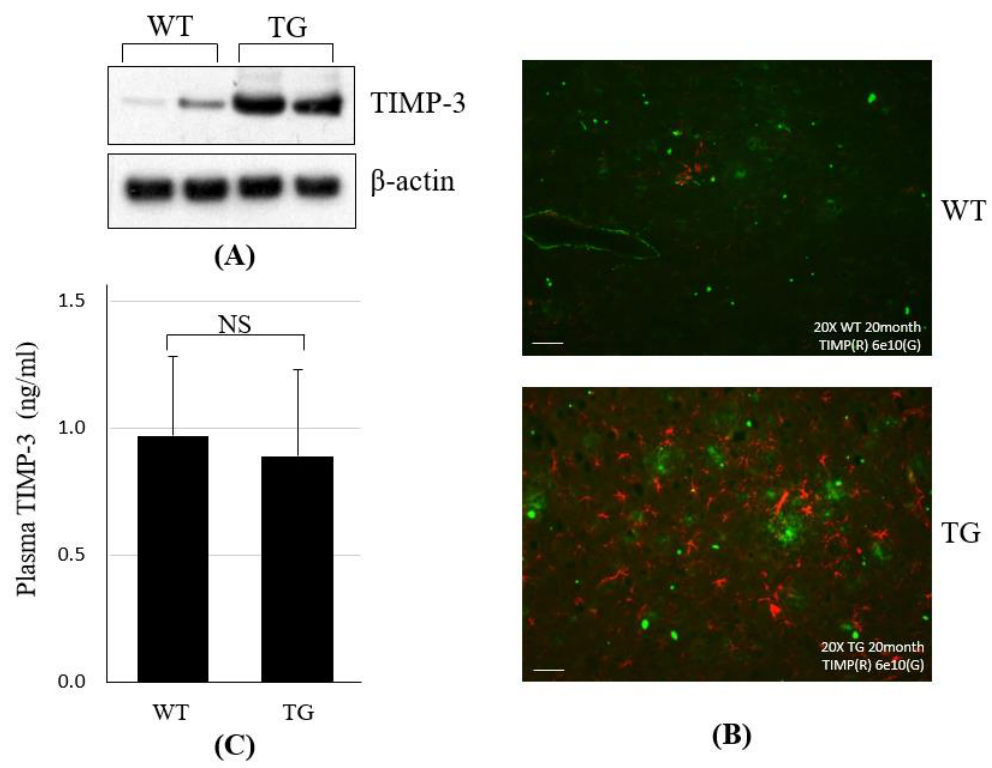
Figure 1. ( A ) Immunoblot analysis for TIMP-3 in the cerebral cortex of wild-type (WT) and APP Swedish/PS1dE9 transgenic (APP Tg) mice. β -actin was used as a loading control. ( B ) Detection of TIMP-3 in the parietal cortex of AD mice brains. Immunostainings of anti-TIMP-3 (Red) and anti-A β 1-42 (Green) in the brain of WT and APP Tg mice (scale bar = 50 µ m). ( C ) The plasma TIMP-3 levels of WT ( n = 4) and TG ( n = 4) were measured by ELISA assay. Each value is presented as the mean ± SD. TG, Transgenic; NS, not significant; TIMP-3, Tissue inhibitor of metalloproteinase-3; SD, Standard deviation.